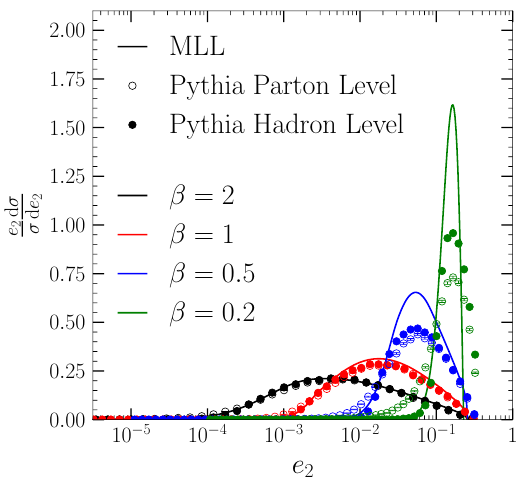
Figure 2 . Dependence on the angular dependence parameter (cid:12) in QCD for p T = 1 TeV jets. We show the predictions derived using the MLL analytic calculation, along with the parton and hadron level numerical results from Pythia . Larger (smaller) angular dependence emphasizes the contribution from pairs of partons with larger (smaller) angular distance. The analytic calculations begin to break down for angular dependence values (cid:12) < 0 : 5 , which is reflected here in the fact that the (cid:12) = 0 : 2 curve does not appropriately terminate at the kinematic